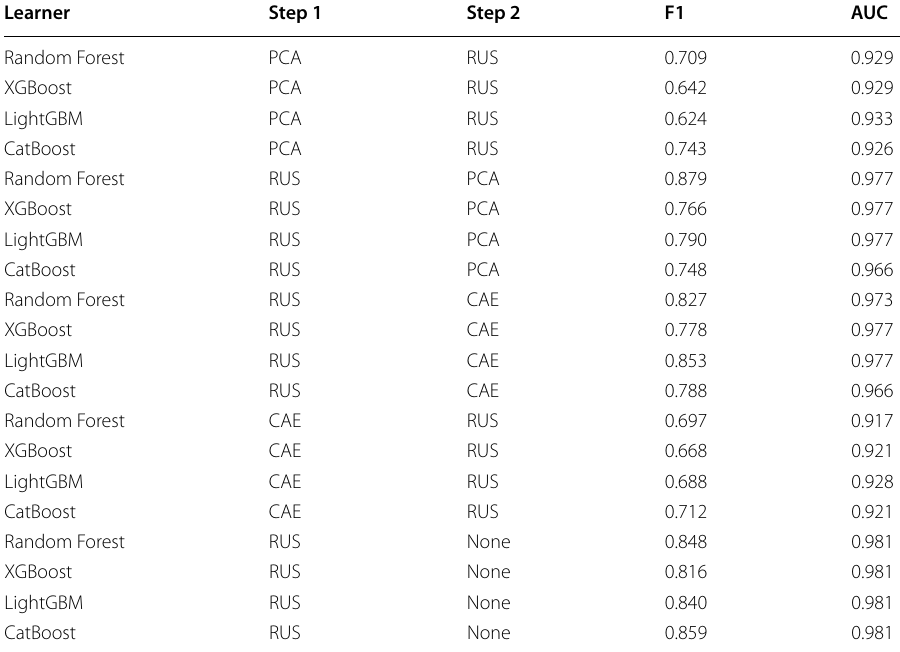
Table 6 Performance scores for RUS (1:20 ratio) Learner